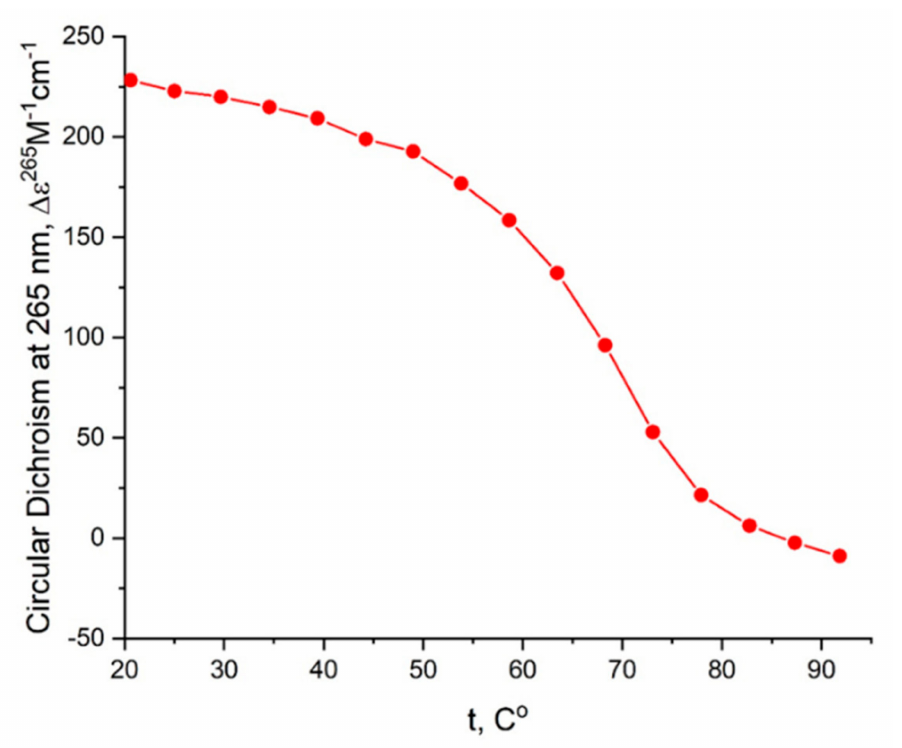
Figure A4. CD melting profile of GQs under study in buffer C (140 mM NaCl, 10 mM KCl, 5 mM BaCl 2 ): AS1411